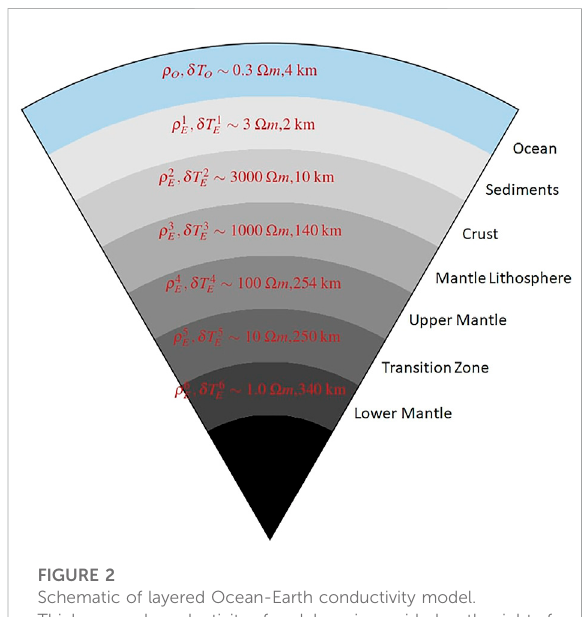
FIGURE 2 Schematic of layered Ocean-Earth conductivity model. Thicknessandconductivityofeachlayerisprovidedontherightof the fi gure. Name of each layer is also mentioned in the fi